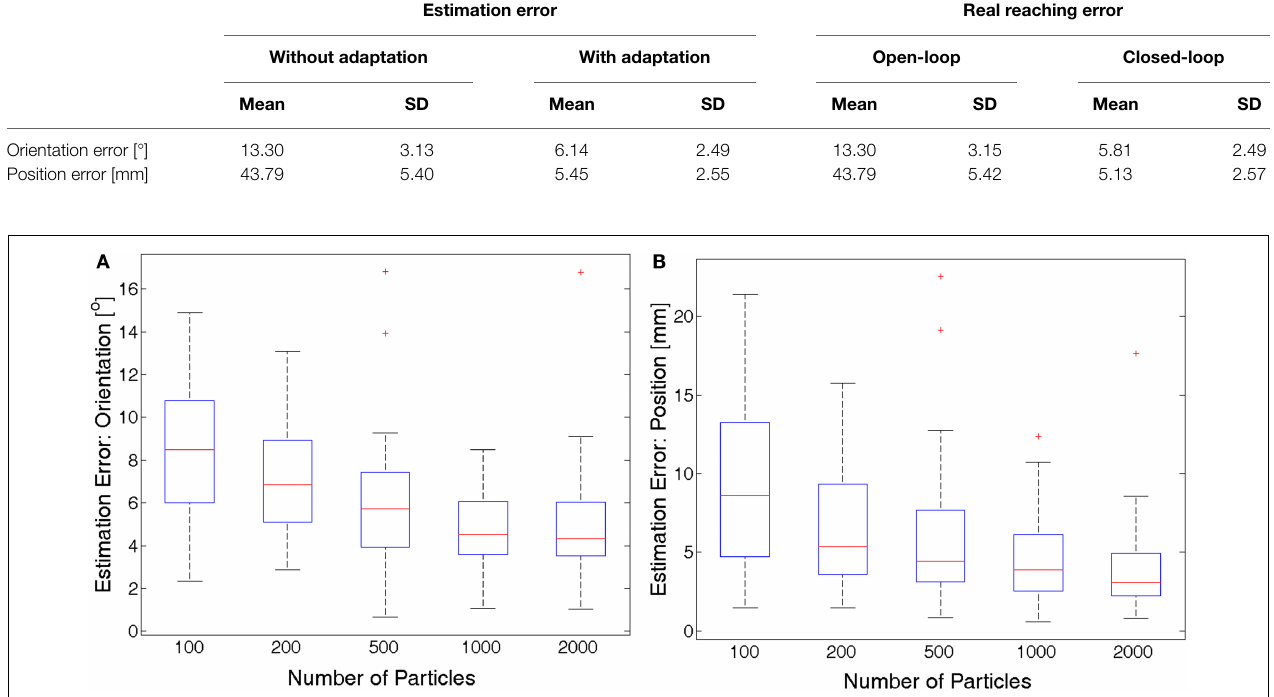
FIGURE 9 | Comparing the final estimation error (orientation (A) and position (B)) using different amount of particles . The mean value of the error over 40 movements is shown. The accuracy increases with the number of particle used in anon-linear way, and it seems to stabilize after 1000 particles.